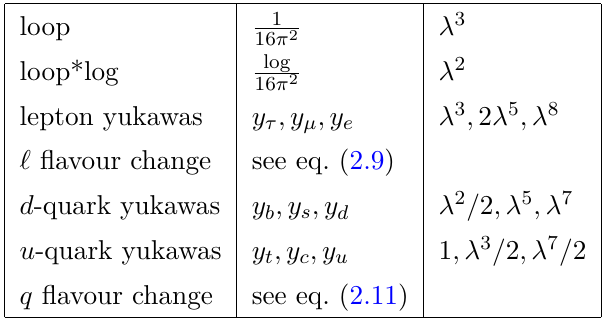
Table 2 . Power-counting scheme for the perturbative expansion of the